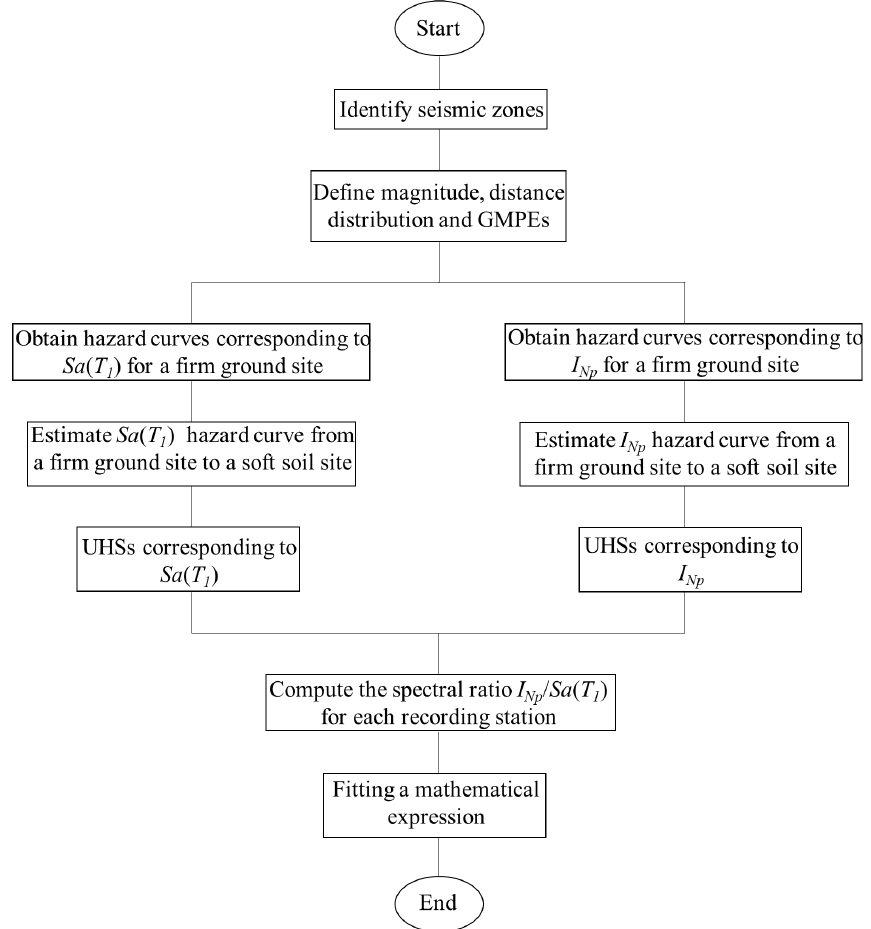
Figure 1. Block diagram of the proposed